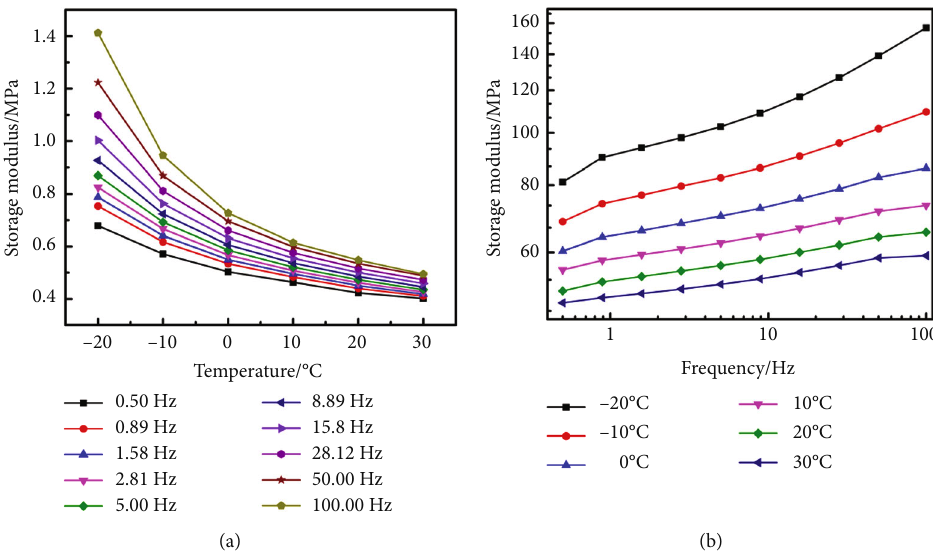
Figure 1: (a) The temperature curves of the storage modulus at di ff erent frequencies are closer and closer as the temperature increases. (b) Frequency curve of storage modulus at di ff erent temperatures. The lower the temperature, the greater the change with